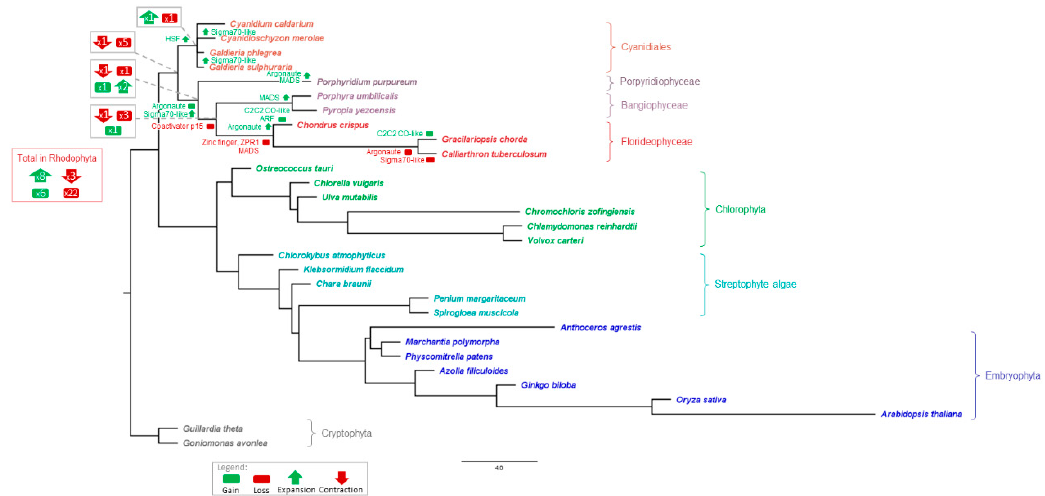
Figure 6. Species tree showing predicted TAP gains, losses, contractions, and expansions. The outgroup-rooted tree is based on the species tree published by the one thousand plant transcriptomes (1kp) consortium [26] and was modified by restriction to the species analyzed here (cf. Materials and Methods, Section 2.5). Selected gains, losses, contractions, and expansions detected by asymmetric Wagner parsimony and discussed in the text are marked by green (gain) and red (loss) boxes, as well as green (expansion) and red (contraction) arrows in the tree. The gray framed boxes at the nodes defining the Cyanidiales, red algae, Bangiophyceae/Florideophyceae/Porphyridiophyceae, and the Bangiophyceae/Florideophyceae respectively, show the total number of gains/losses/expansions/contractions detected at these nodes. The red framed box shows the total number of gains/losses/expansions/contractions within all nodes of the red algae. For complete results, see Supplementary Table S5. The species are colored according to the color scheme described in Figure 5, and the brackets indicate taxonomic groups.